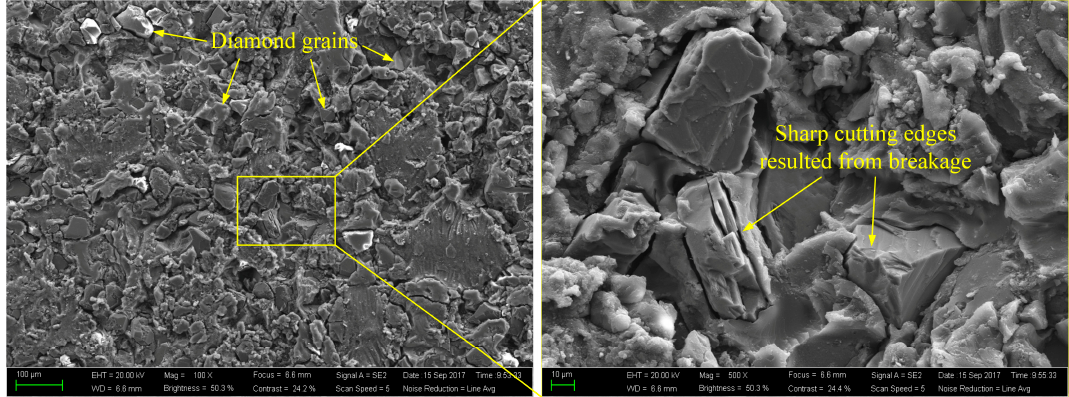
Figure 8. Surface morphology of the form-trued spherical diamond wheel.